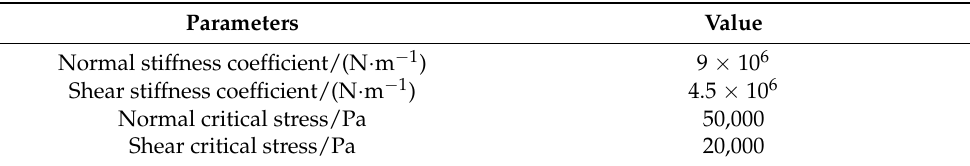
Table 2. Bond parameters of frass particles.